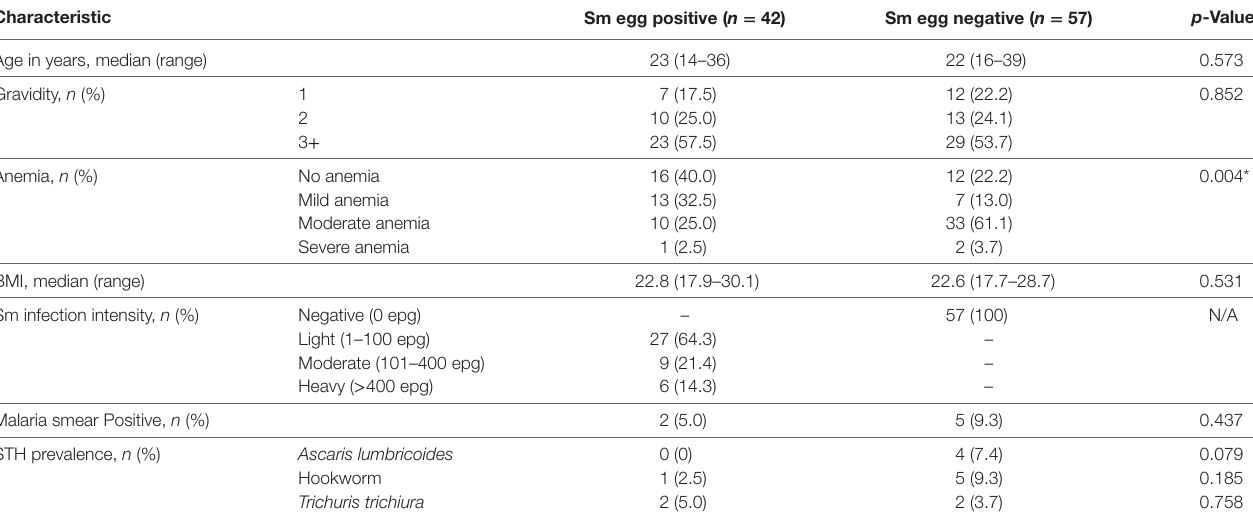
TaBle 1 | Characteristics of pregnant women ( n = 99) from western Kenya enrolled in the cohort study.